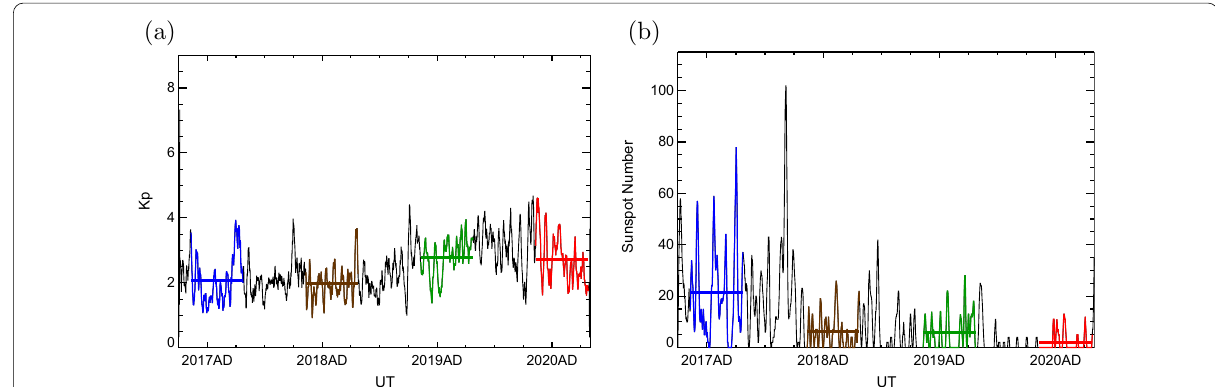
Fig. 6 Variations of (a) Kp index and (b) sunspot number during the years of the analyzed Kannuslehto campaigns. The horizontal lines show the mean values of given parameters within the analyzed campaign intervals